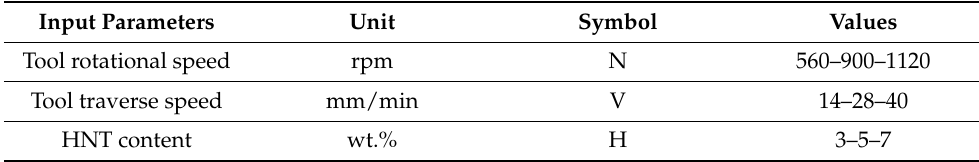
Table 1. Input parameters and values of each